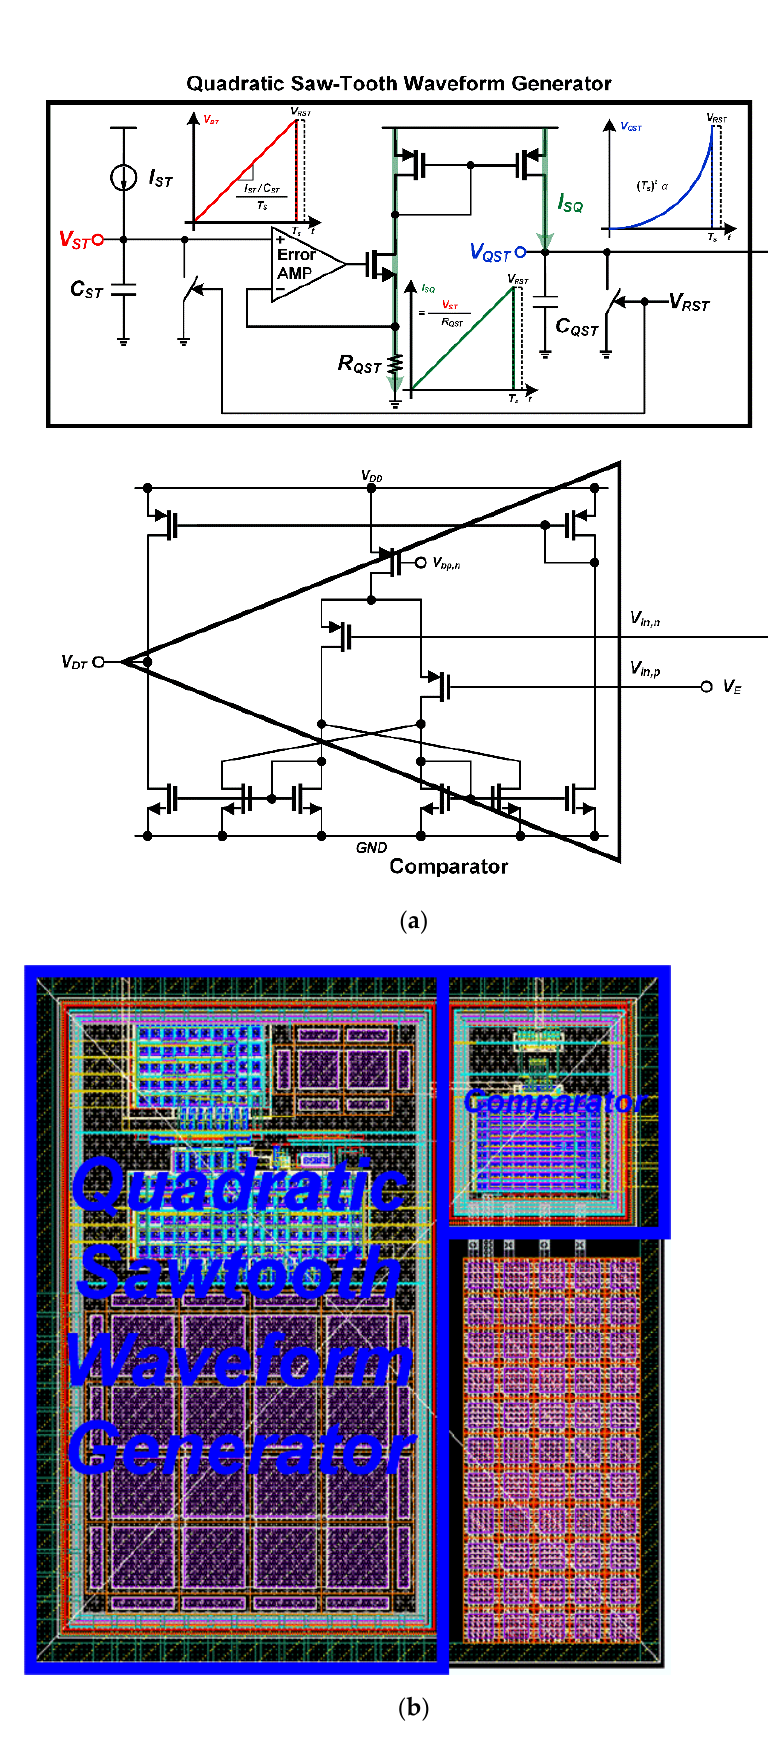
Figure 9. Detailed implementation of PWM generator: ( a ) schematic; ( b ) layout.